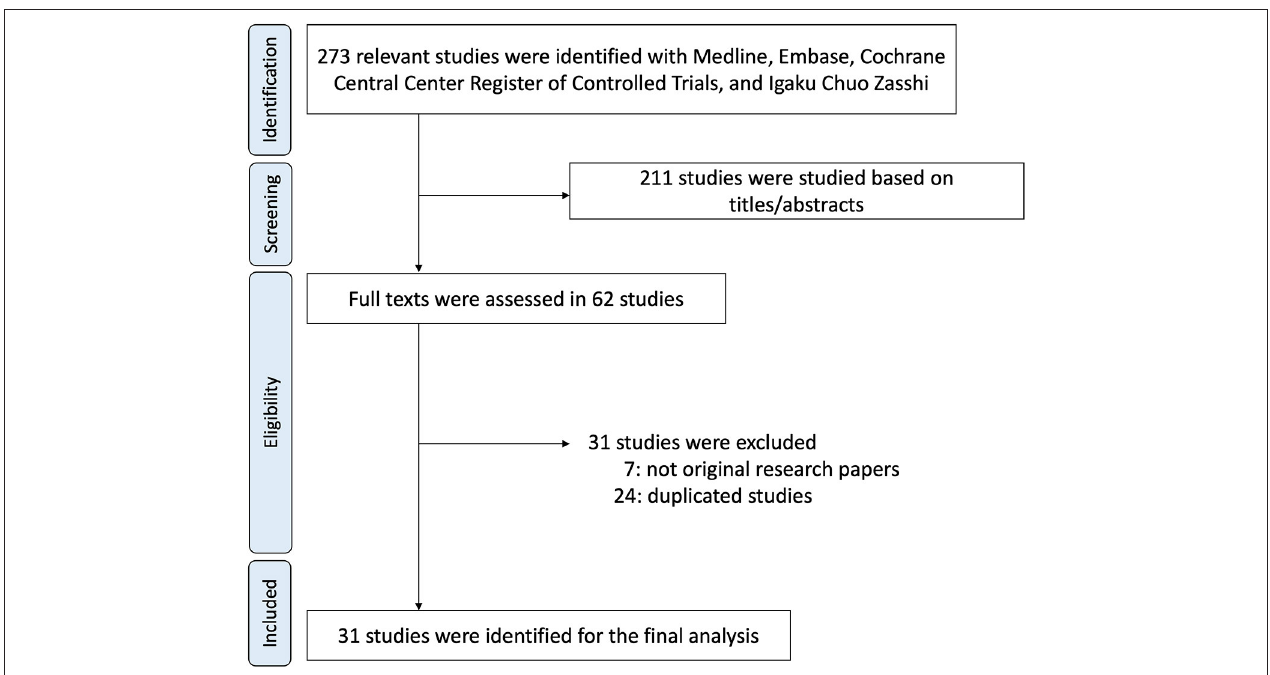
FIGURE 1 | Flow chart of the